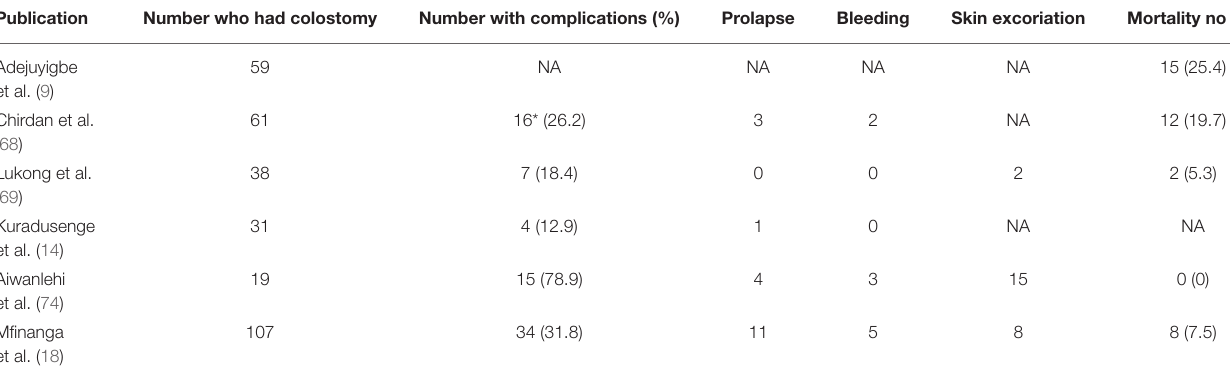
TABLE 2 | Common complications following colostomy for patients with anorectal